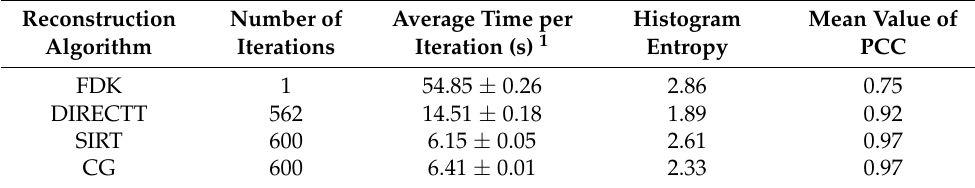
Table 1. Comparison of the performance of the reconstruction algorithms.